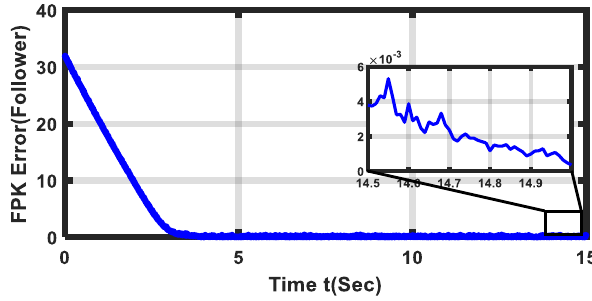
Figure 8. FPK equation error of follower 1 in group